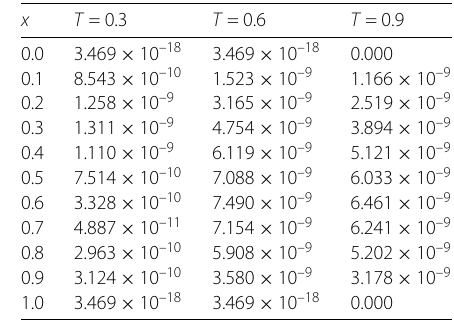
Table 2 For Example 6.2, the absolute error results in different cases of the final time T when n = 3, φ ( h ) = –(exp(–1.2 h ) –